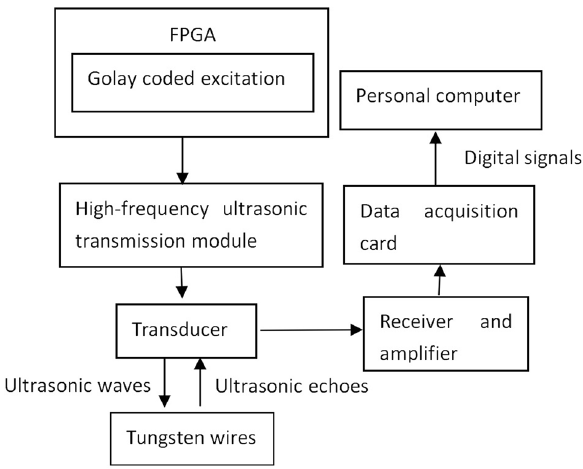
Figure 9. Block diagram of the echo experimental